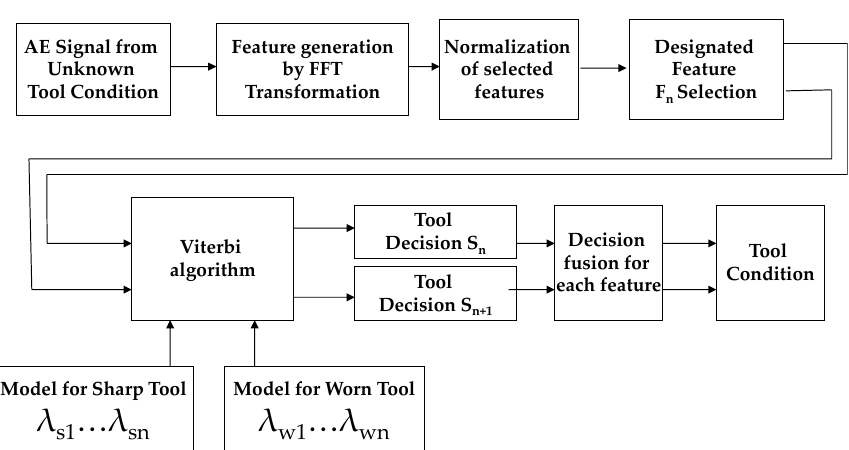
Figure 2. Schematic of HMM model development.